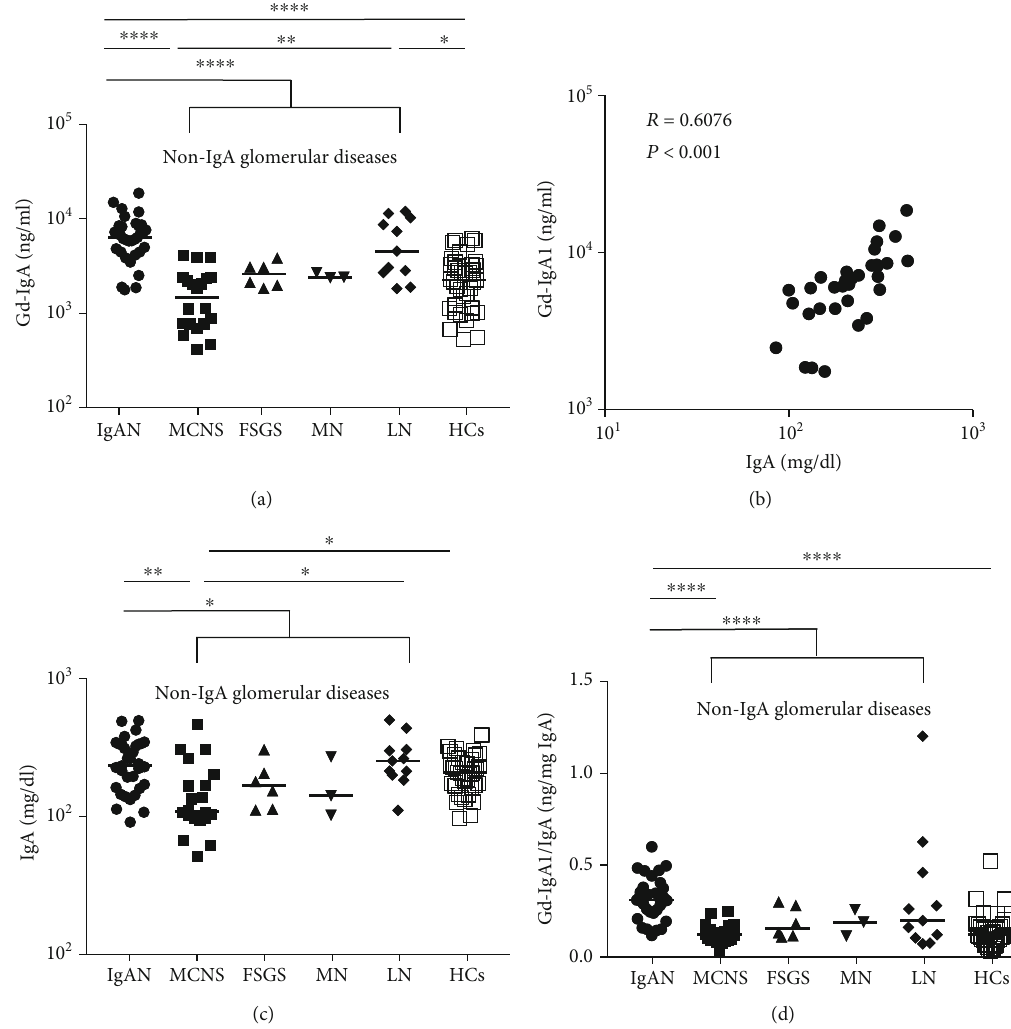
Figure 1: Serum Gd-IgA1 levels, serum total IgA levels, and serum Gd-IgA1/total IgA ratio in children with various glomerulopathies. (a) Serum Gd-IgA1 levels. (b) The correlation between serum Gd-IgA1 levels and serum total IgA levels. (c) Serum total IgA levels. (d) Serum Gd-IgA1/total IgA ratio. Bars represent median values. Statistically signi fi cant di ff erences between each patient group are shown as ∗ p